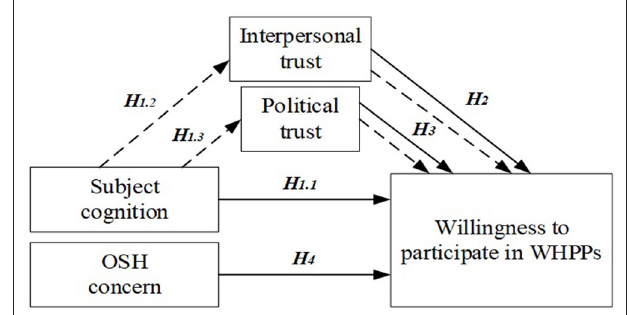
FIGURE 1 | Conceptual model of the